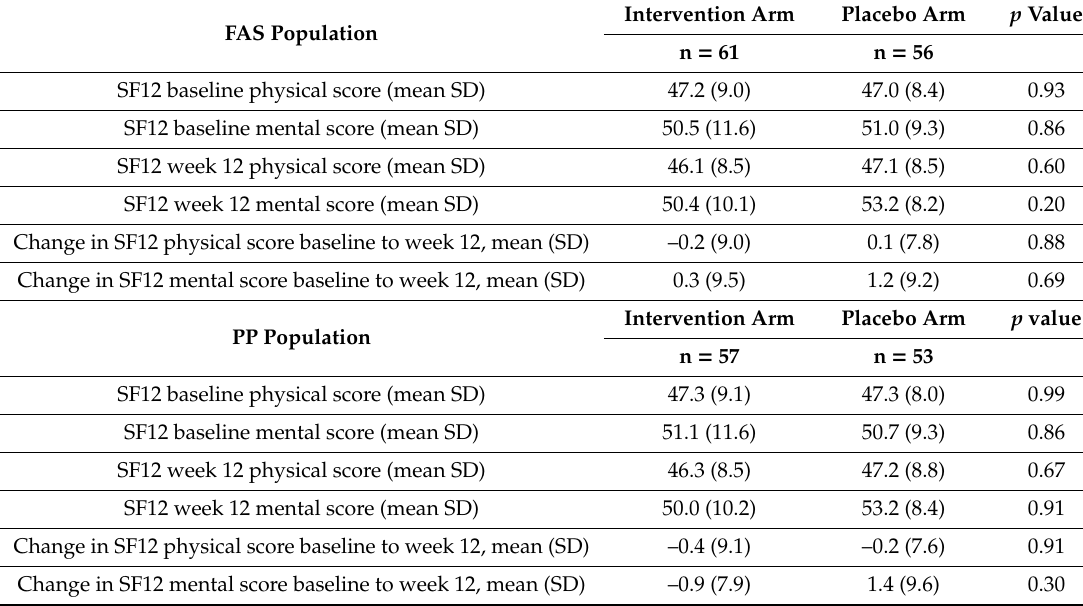
Table 5. SF12 at baseline and at 12